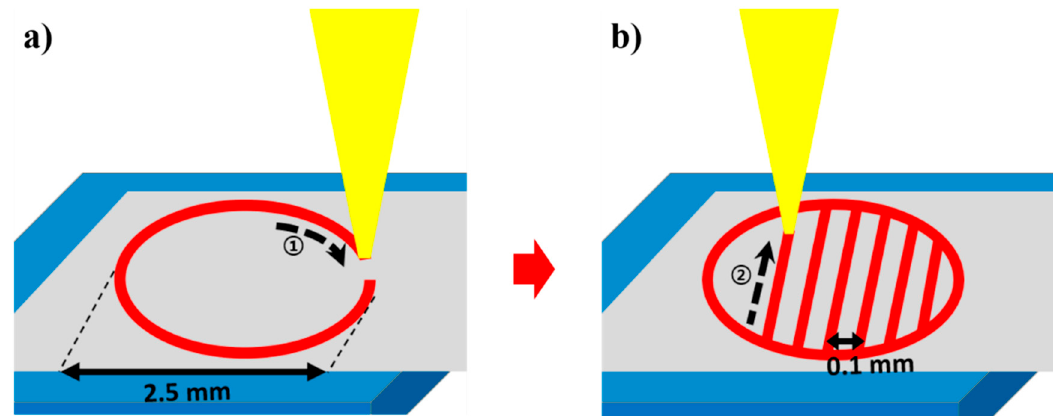
Figure 2. Illustration of the welding path. ( a ) Circular; ( b ) hatching.